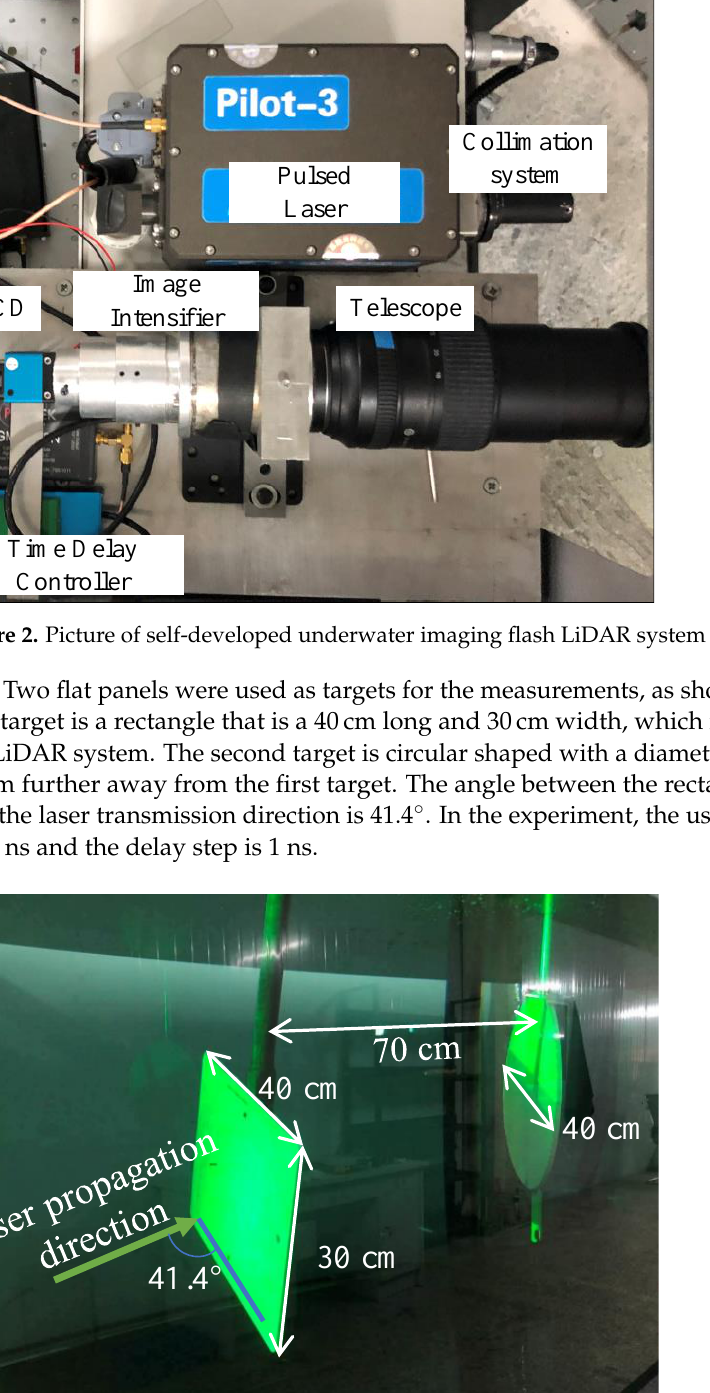
Figure 3: Optical image of underwater targets used for 3D image reconstructions. The first target is a rectangular panel and the second one is a circular panel. The distance between these two targets is 60 cm. During the underwater imaging process, the intensity distribution of the images acquired by ICCD is not uniform due to the uneven distribution of the laser light intensity field irradiated on the target surface. Figure 4a–f present the intensity images acquired by ICCD at different delay time, respectively. From these images, it can be found that this nonuniform intensity phenomenon is more obvious for the front rectangular